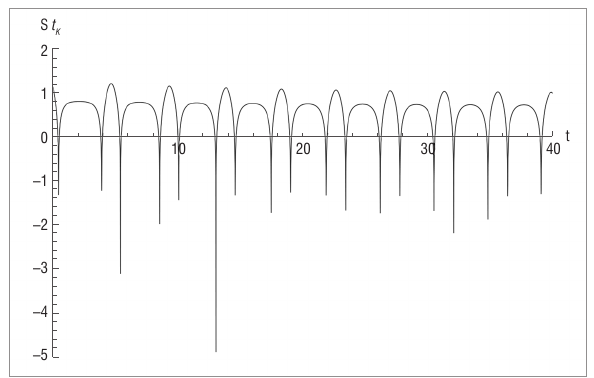
Figure 1: A downward spike occurs whenever y ( t